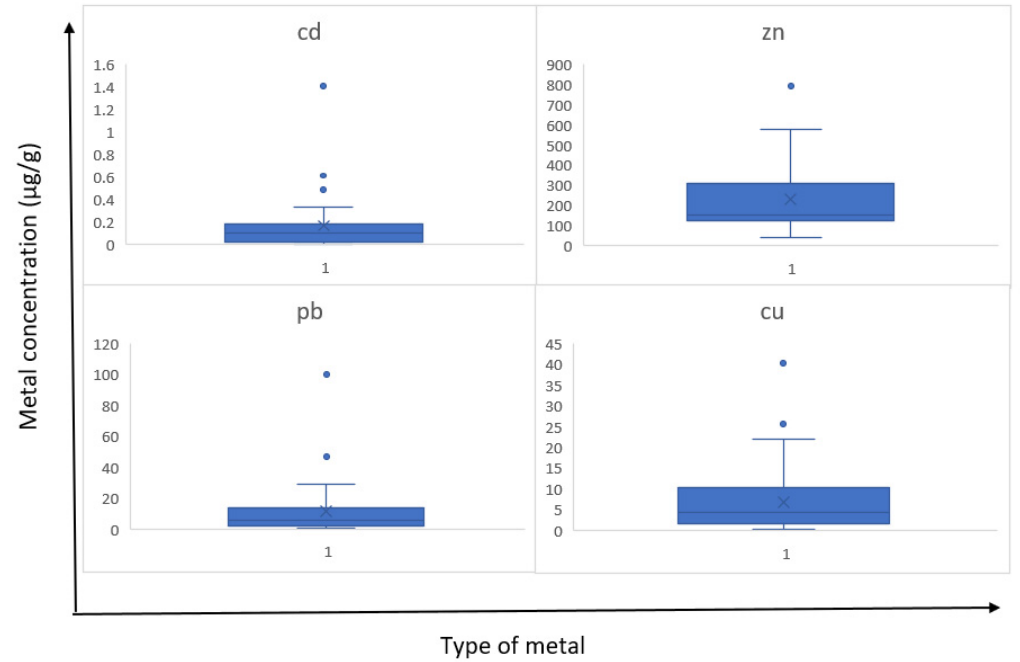
Figure 3. Boxplot of Zn, Cd, Pb, and Cu concentrations in the samples. The minimum (0th percentile), maximum (100th percentile), median (50th percentile), first quartile (25th percentile), and third quartile (75th percentile), clearly show the data scatter in the first, second, third, and fourth quartiles. The most dispersion was shown in the fourth quartiles.